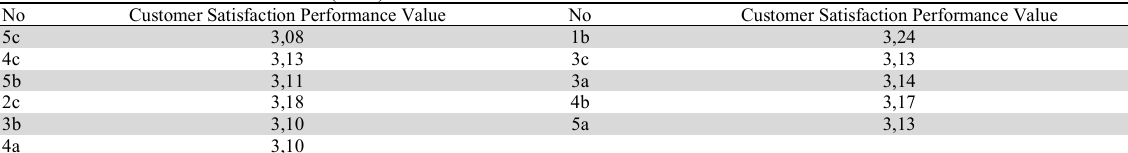
Customer Satisfaction Performance (CSP) Value